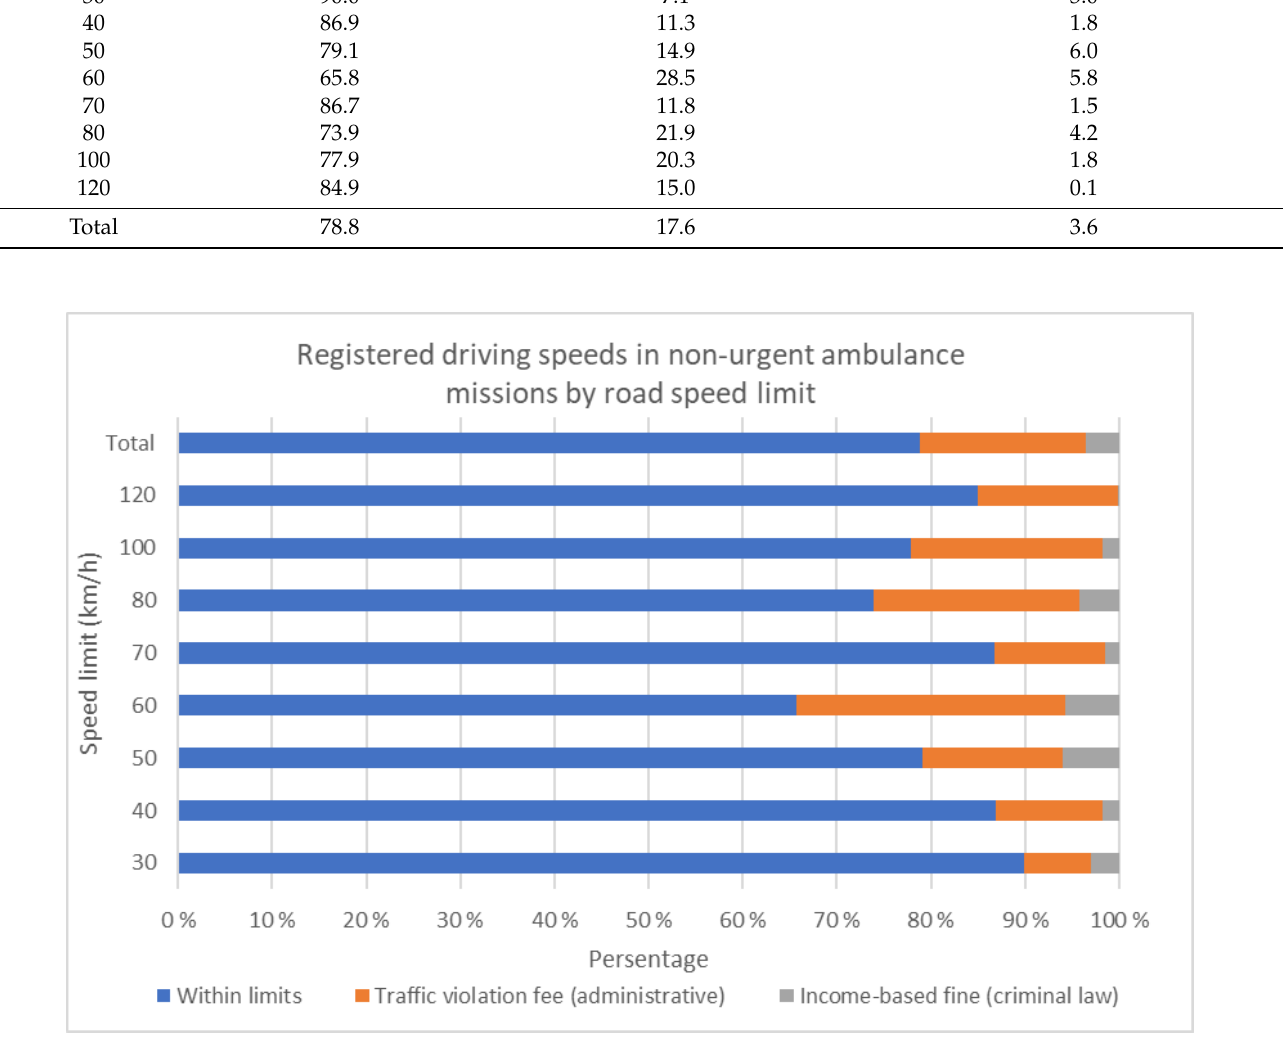
Figure 1. Registered driving speeds in non-urgent ambulance D-missions by road speed limit.